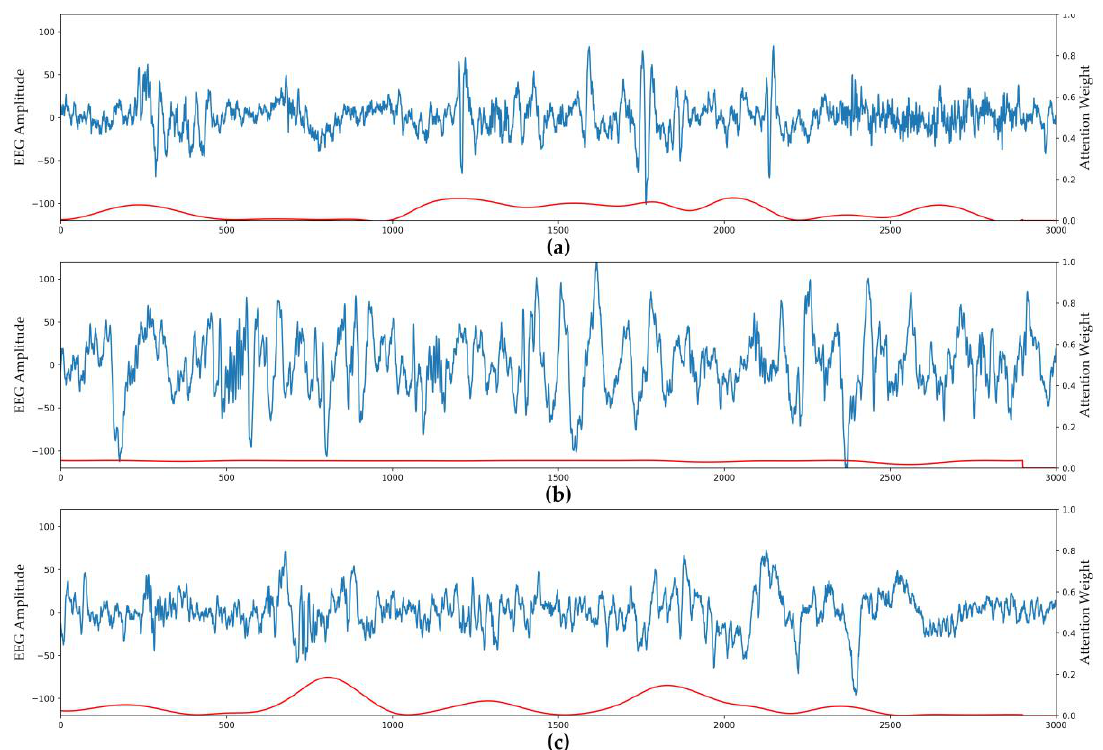
Figure 6. Attention weights visualization of different stages. The blue line is the raw EEG signal and the red line is the corresponding attention weights: ( a ) stage N2; ( b ) stage N3; ( c ) REM stage.